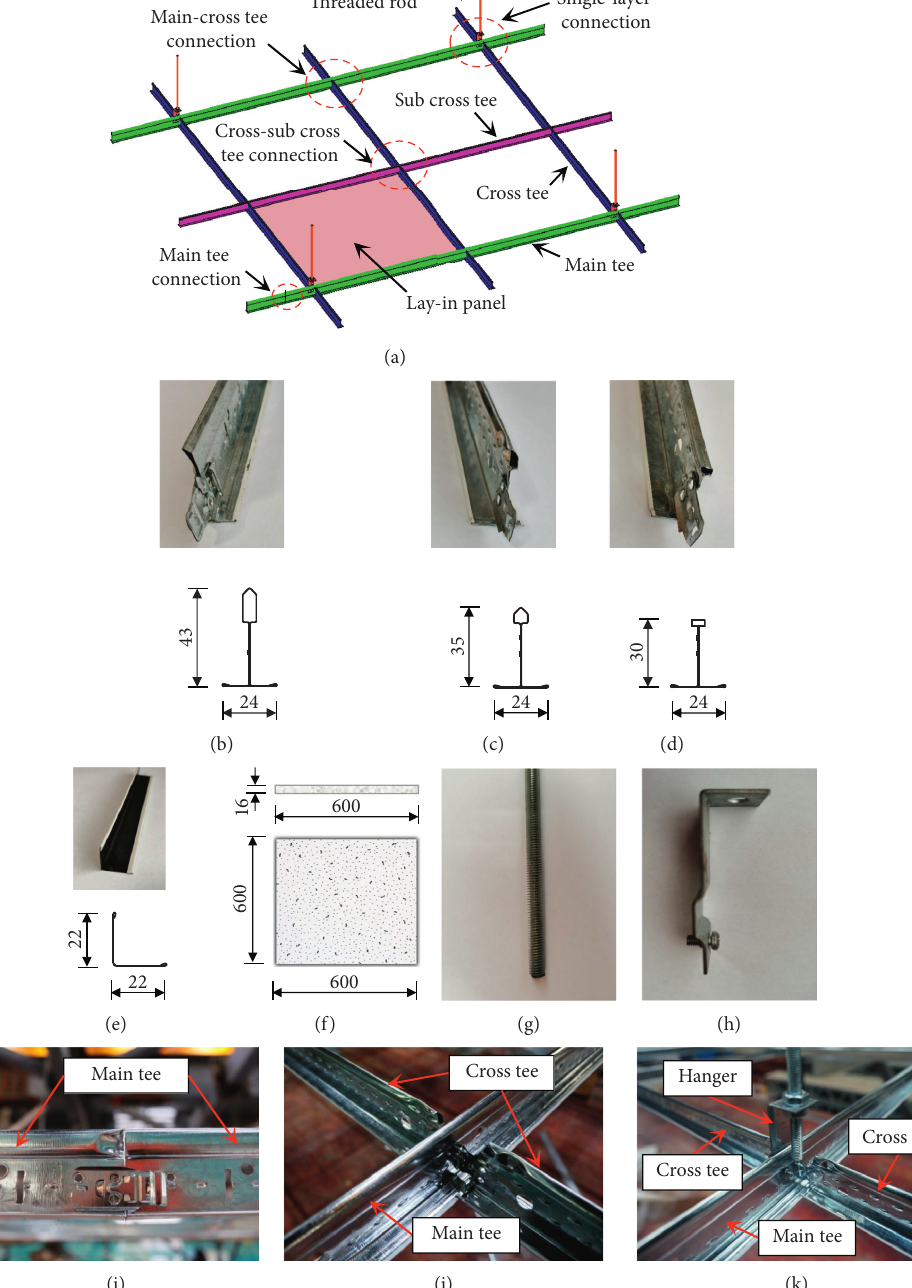
Figure 1: Constitution of Chinese-style single-layer suspended ceiling system. (a) Single-layer ceiling, (b) main tee, (c) cross tee, (d) sub cross tee, (e) wall angle, (f) lay-in panel, (g) threaded rod, (h) hanger, (i) main tee connection, (j) main-cross tee connection, and (k) single- layer